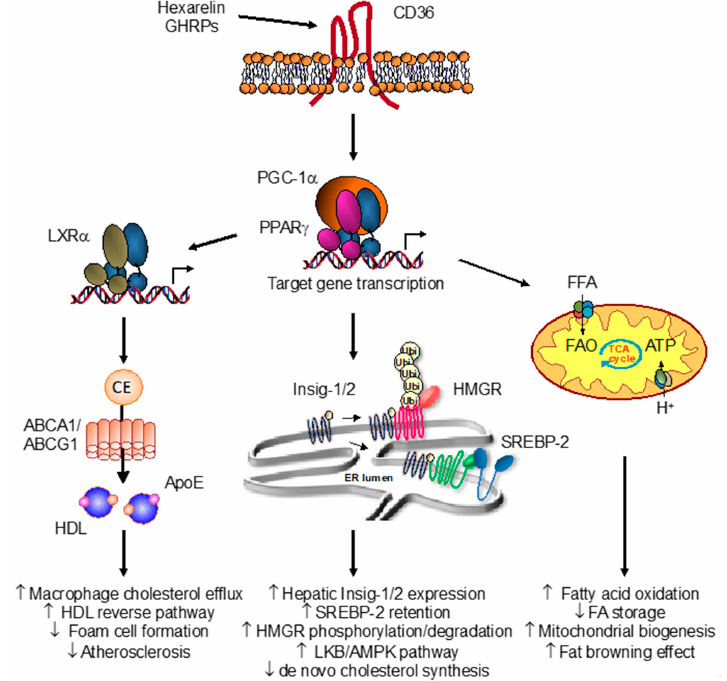
Figure 1. Overview of the growth hormone releasing peptide (GHRP)-peroxisome proliferator-activated receptor-gamma (PPAR γ ) pathway in lipid and energy metabolism. The interaction of hexarelin with the scavenger receptor CD36 promotes the transcriptional activation of nuclear receptor PPAR γ and target gene profiling involved in metabolism. In macrophages, hexarelin and other GHRPs induce a molecular cascade involving nuclear liver X receptor LXR α and expression of apolipoprotein E (apoE) and sterol transporters ABCA1 and ABCG1. Such activation of the PPAR γ -LXR α -ABC metabolic pathway increases cholesterol efflux, resulting in enhanced HDL reverse cholesterol transport and regression of atherosclerosis. In hepatocytes, CD36 activation by hexarelin reduces de novo cholesterol synthesis. Activation of the LKB-AMPK pathway resulted in the inhibition of the rate-limiting 3-hydroxy-3-methylglutaryl coenzyme A reductase (HMGR) enzyme. Also, induction of Insig1/2 expression through PPAR γ /PGC-1 α activation led to HMGR degradation and SREBP-2 retention in the endoplasmic reticulum (ER), thereby blunting the homeostatic response to sterol depletion. In adipocytes, CD36 activation with hexarelin promotes mitochondrial activity and biogenesis through enhanced PPAR γ and co-activator PGC-1 α transcriptional activity. Induction of key genes involved in fatty acid utilization and energy production in mitochondria results in an increased fatty acid β -oxidation and thermogenic-like profile indicative of a browning effect of white fat (adapted from Refs